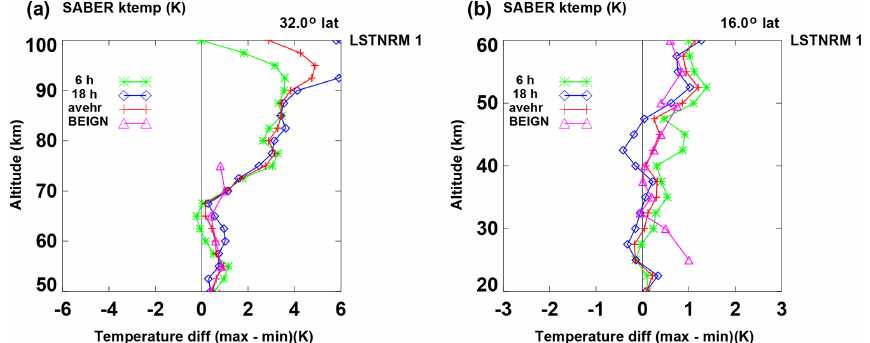
Figure 5. Corresponds to Fig. 3, but for temperature responses to solar activity versus altitude, from 50 to 100km (a) , and 20 to 60km (b) . Values are responses at solar max minus responses at solar min (K/100sfu). Magenta triangles denote results by Beig et al. (2012), average of 6 and 18LST (composite 0–30 ◦ N). Red plusses denote our estimate (average of 6 and 18LST at 32 ◦ N, a and 16 ◦ N, b ), based on SABER data. Green asterisks denote our estimates at 6LST, and blue diamonds are estimates at 18LST.